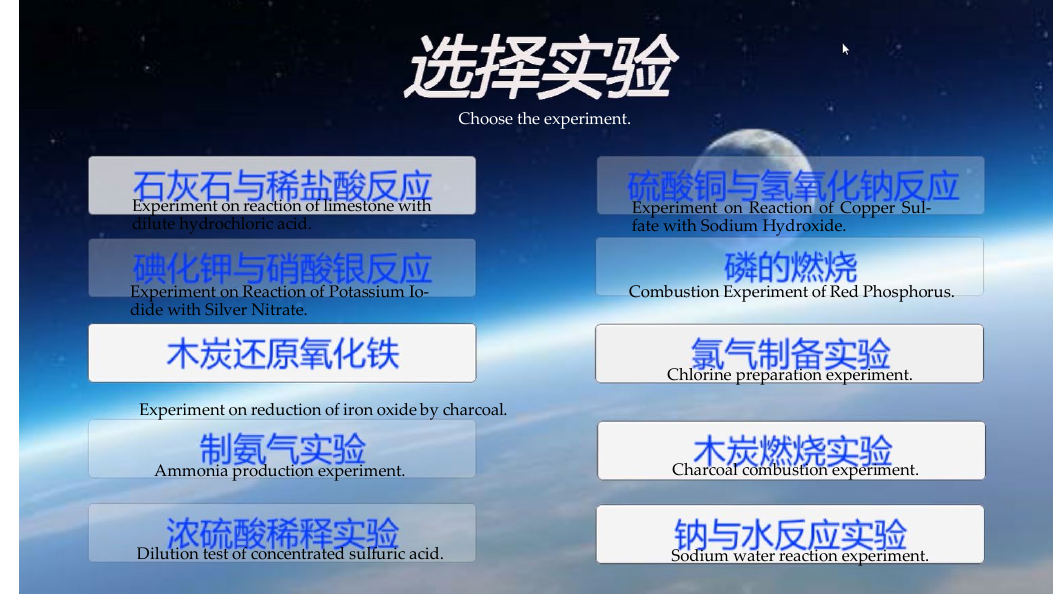
Figure 14. Prototype system interface.